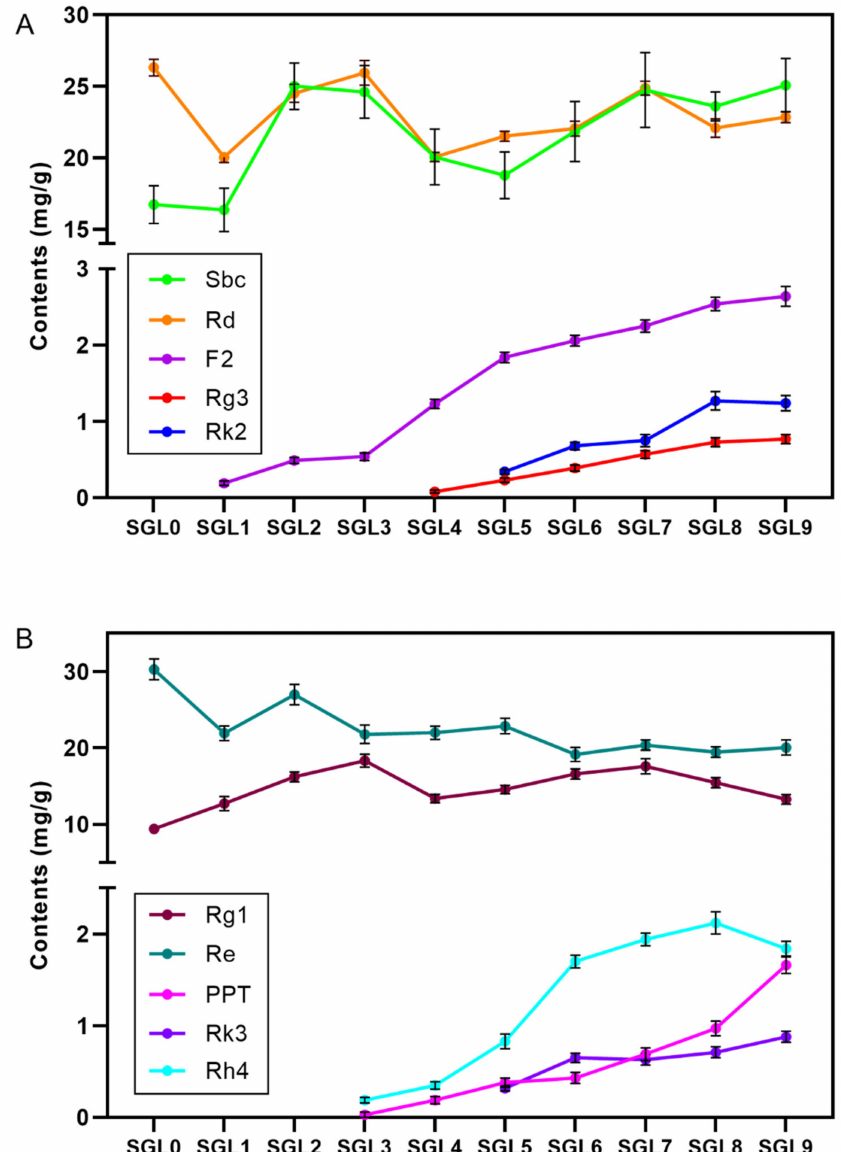
Figure 4. The contents of protopanaxadiol (PPD)-type ginsenosides ( A ) and PPT-type ginsenosides ( B ) during di ff erent steaming batches. Sbc refers to the sum of ginsenosides Rb1, Rb2, Rb3, and Rc. Rg3 refers to the 20S-Rg3 and